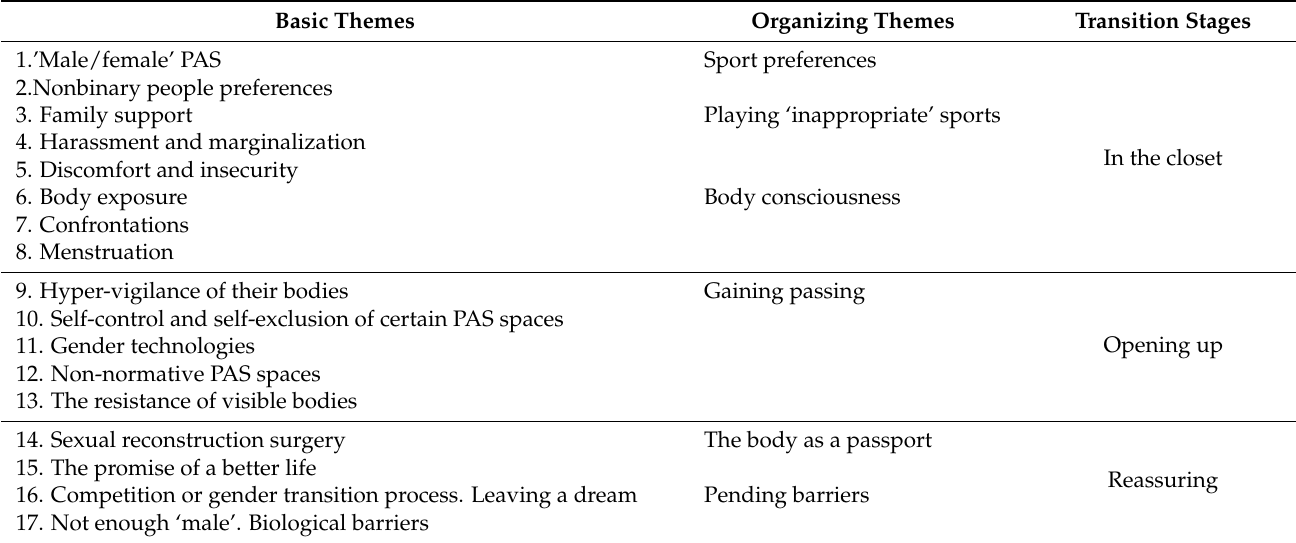
Table 2. Basic themes and organizing themes according to transition